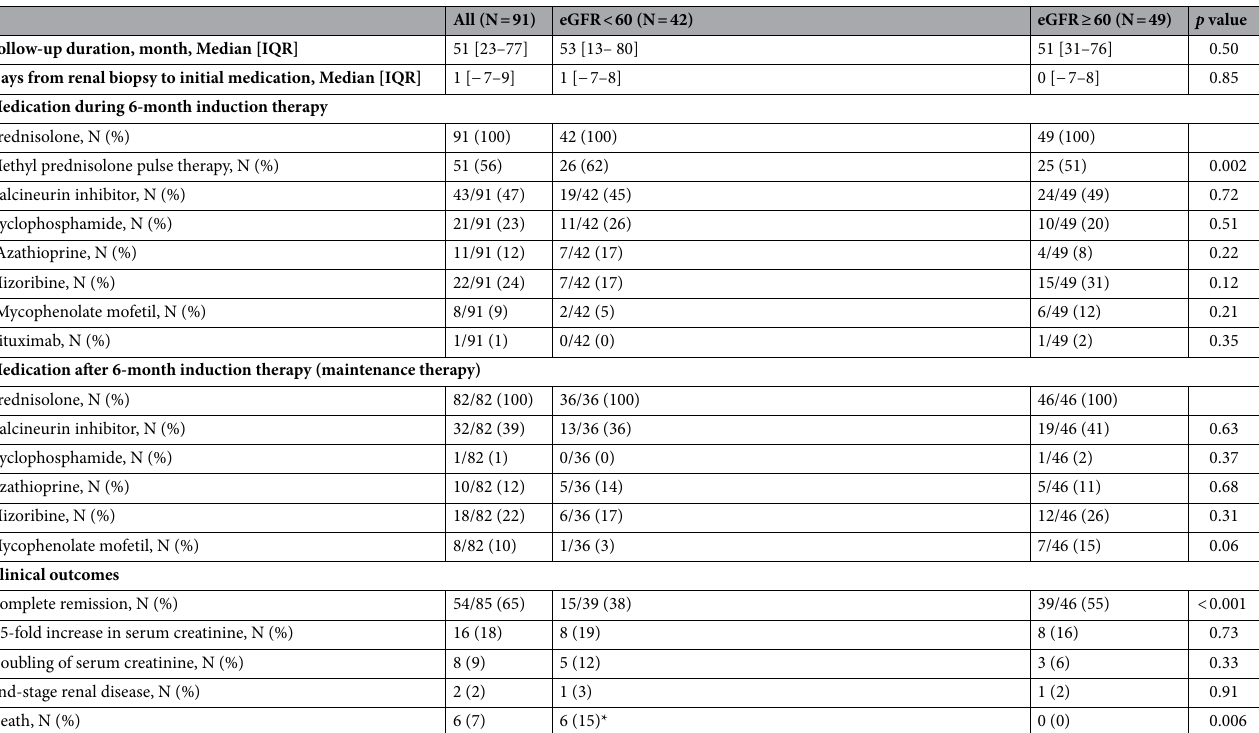
Table 3. Medication during 6-month induction therapy and clinical outcomes. N number, eGFR estimated glomerular filtration rate, IQR interquartile range. *Cause of death; Sepsis (N = 3), Pneumonitis (N = 1), Upper gastrointestinal bleeding (N = 1), Cerebral breeding (N =